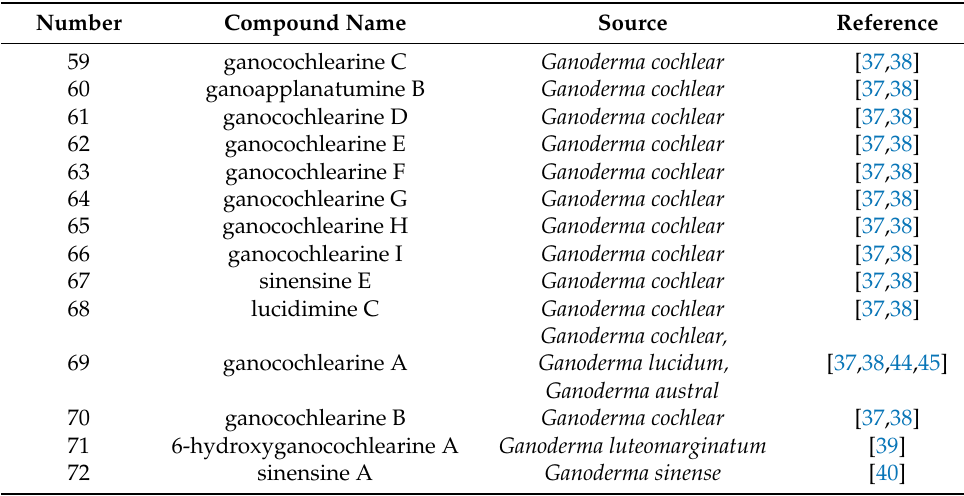
Table 6. Phenyl-substituted Cyclopenta[c]pyridine Derivatives (Type